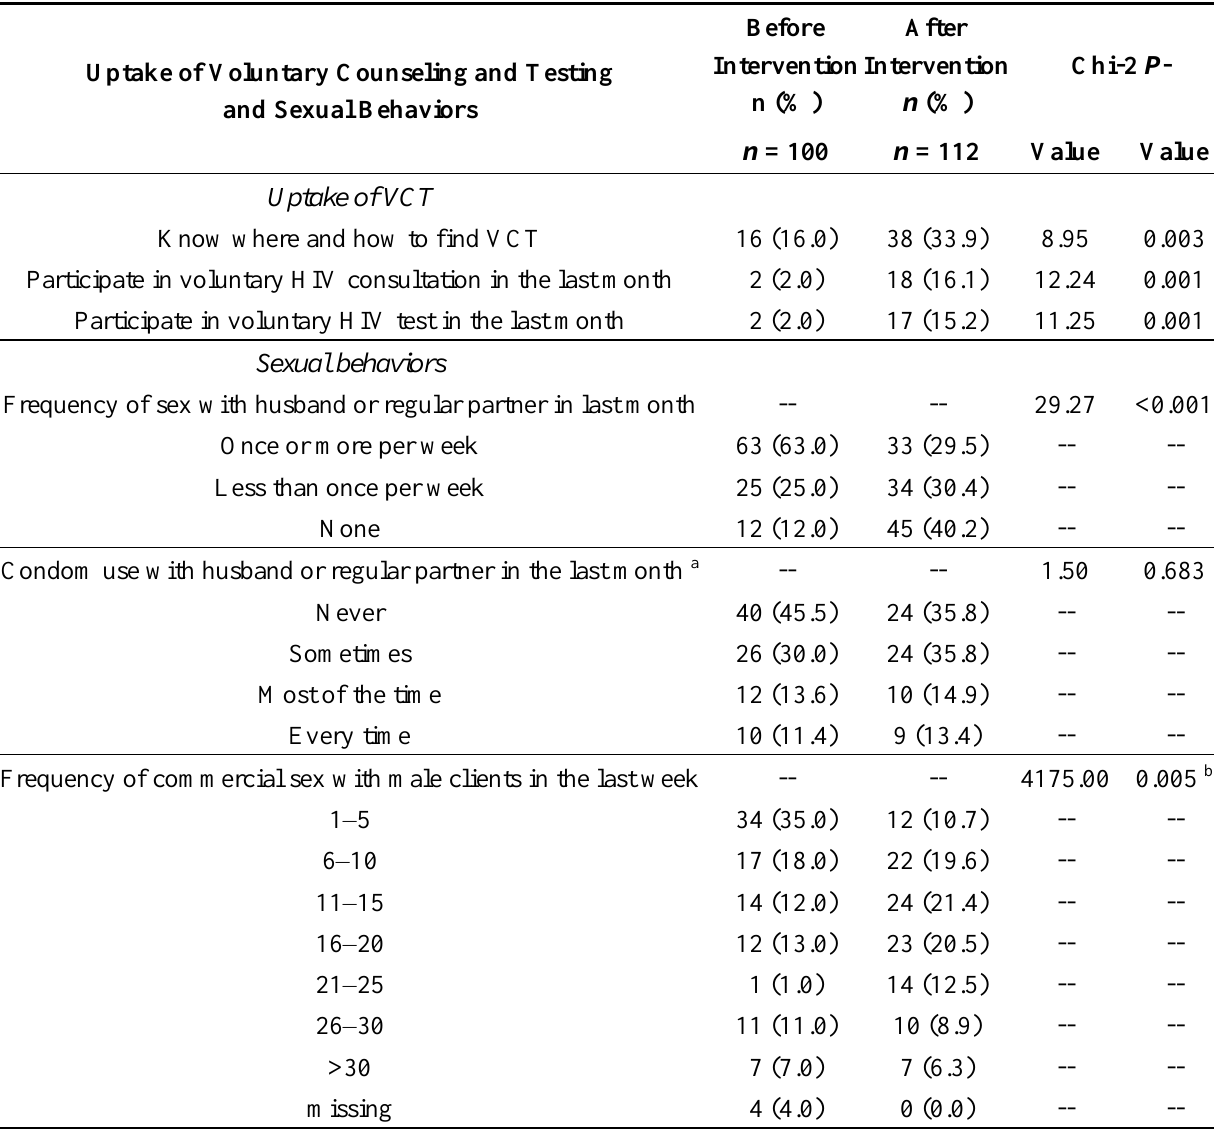
Table 2. Uptake of voluntary counseling and testing and sexual behaviors of street-based sex workers before and after intervention, Chongqing, Southwest of China,